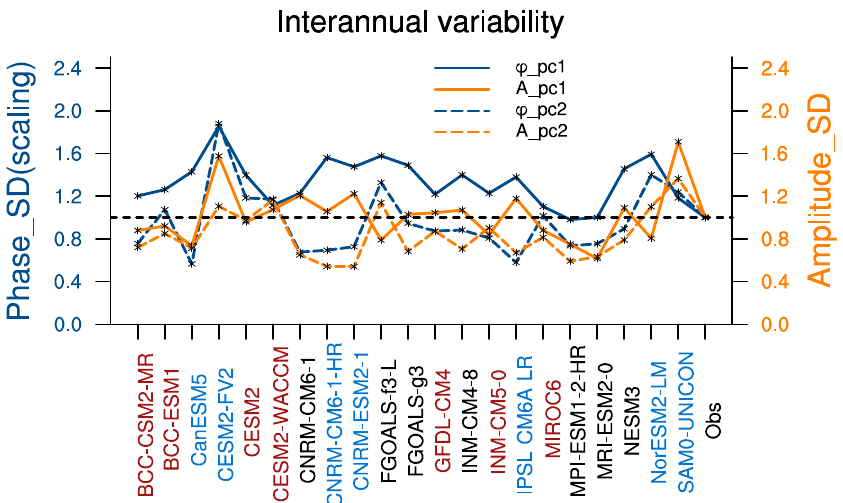
Figure 8. Interannual variabilities of the projected amplitude ( A proj ) and phase ( ϕ proj ) of the annual cycle modes. The solid and dashed curves represent the interannual standard deviations (ISDs) of M1 and M2, respectively. The orange and dark blue curves represent the ISDs of the projected amplitude and phase. The ISDs for the individual models are scaled by the corresponding values in the observations. The dashed black line indicates the ISDs in observation (=1.0 after scaled). The red (blue) tick marks of abscissa represent the relative good (bad) four ISDs performances which close (departure) to the observed ISDs (dashed black line).